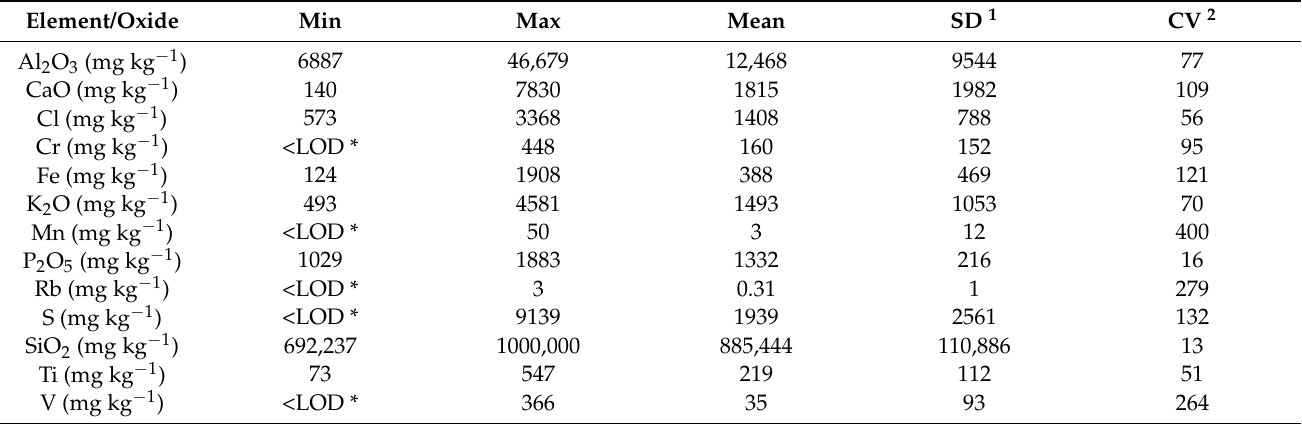
Table 1. Descriptive statistics for the 16 samples of 6 different varieties of quartz obtained with portable X-ray fluorescence ( p XRF) spectrometry data.